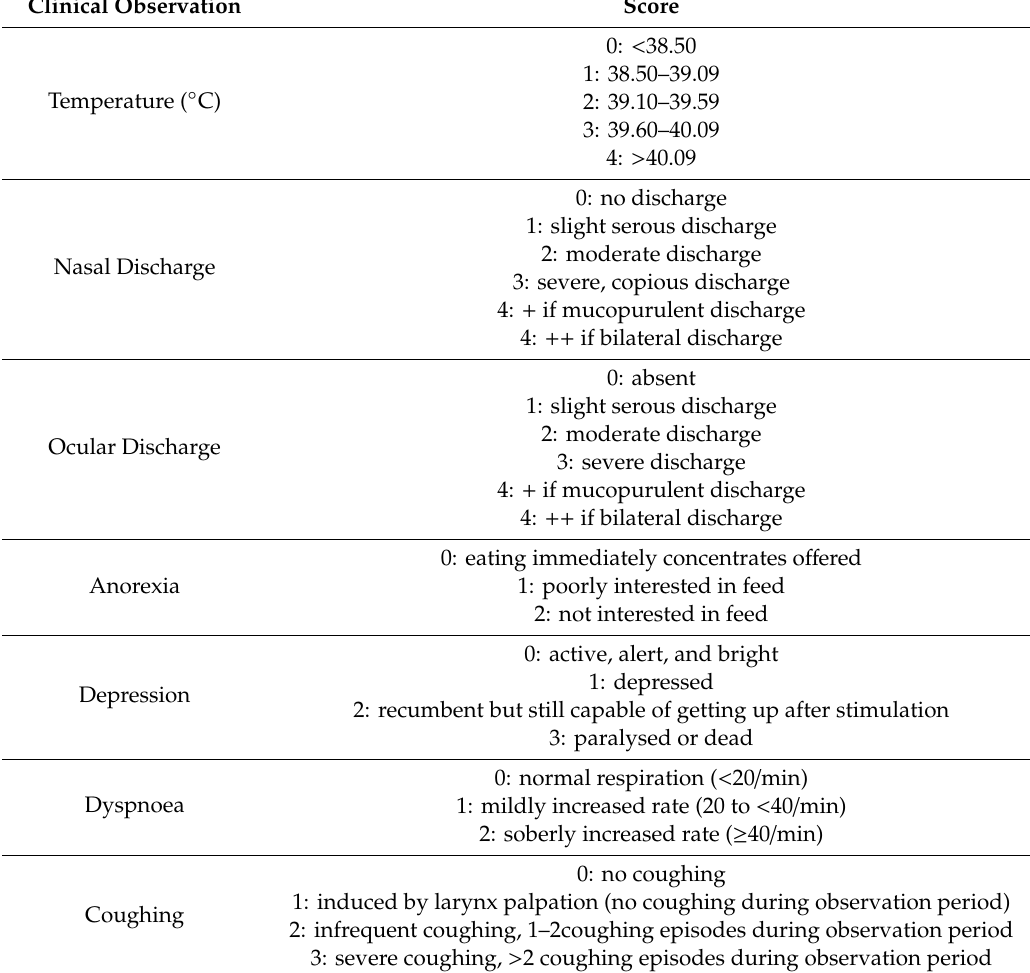
Table 1. The clinical observation scoring